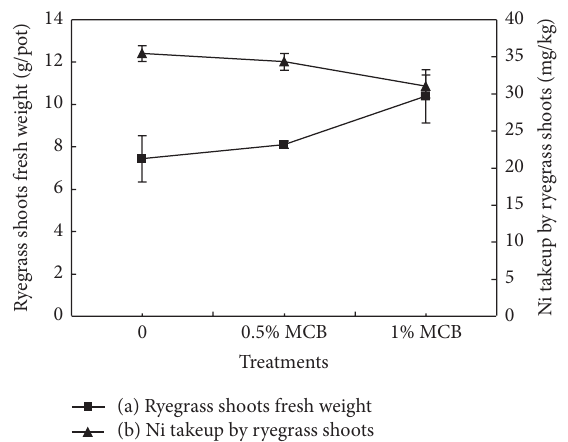
Figure 6: Effect of MCB on the biomass of ryegrass shoots and Ni takeup by ryegrass shoots. Ni 2+ was added to soil at the ratio of 100mg ⋅ kg −1 and the MCB was added at the ratio of 0, 0.5%, and 1%,